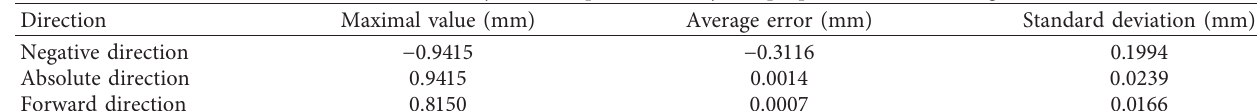
Table 5: Evaluation and analysis of the point cloud by our proposed method for Figure 15.